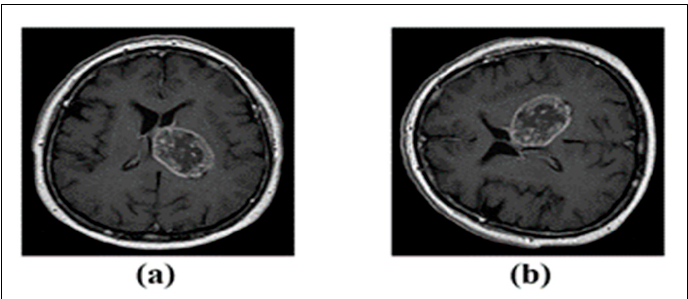
Figure 3. ( a ) Source test case; ( b ) follow-up test case.